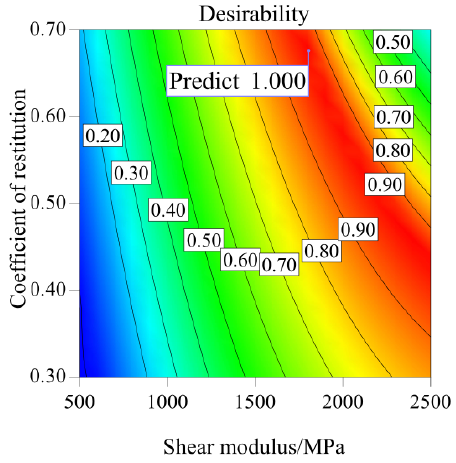
Figure 4. Desirability contour map dominant frequency as an indicator.